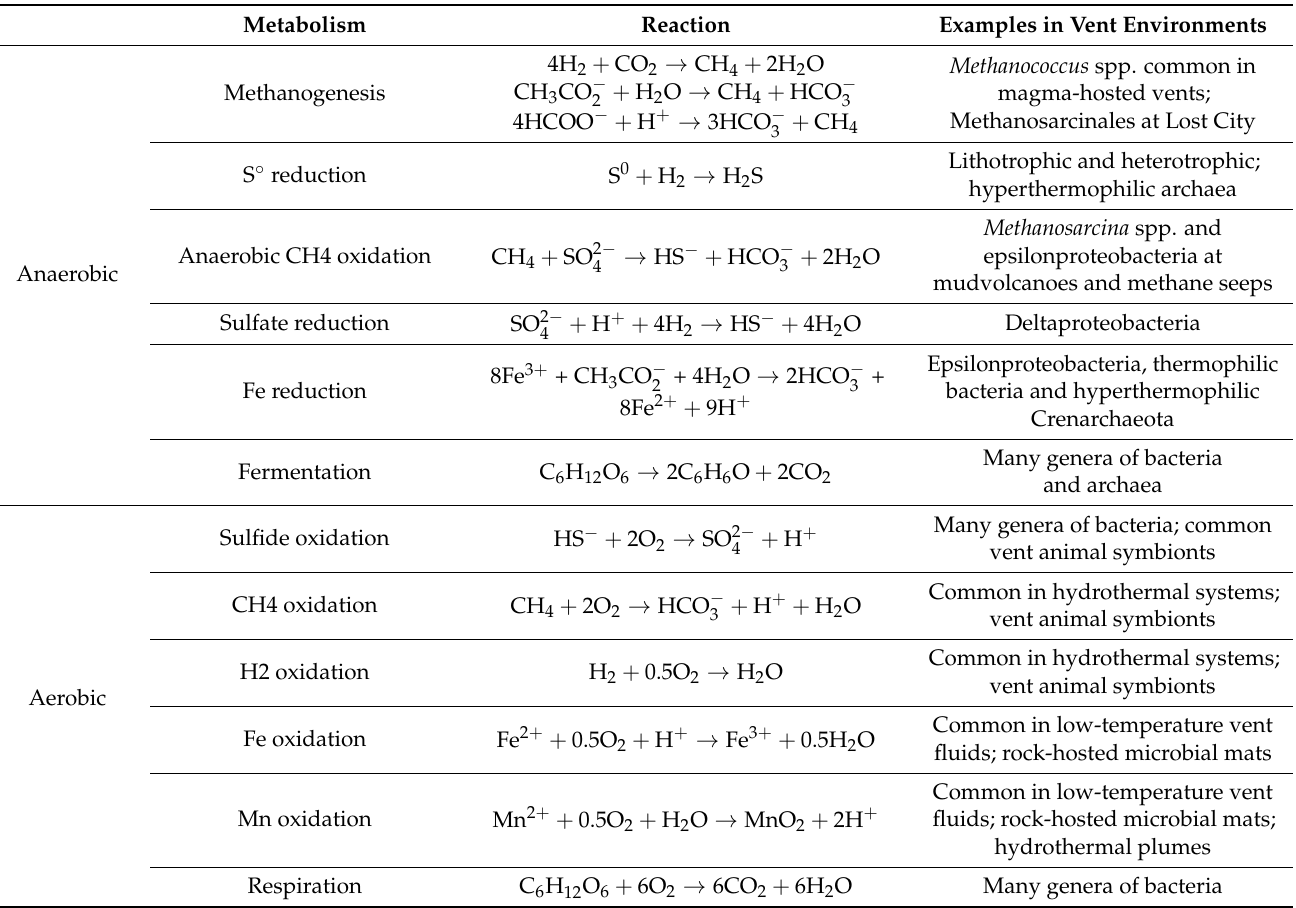
Table 1. Primary metabolic reactions of various microorganisms near hydrothermal solution (cited from Martin et al.